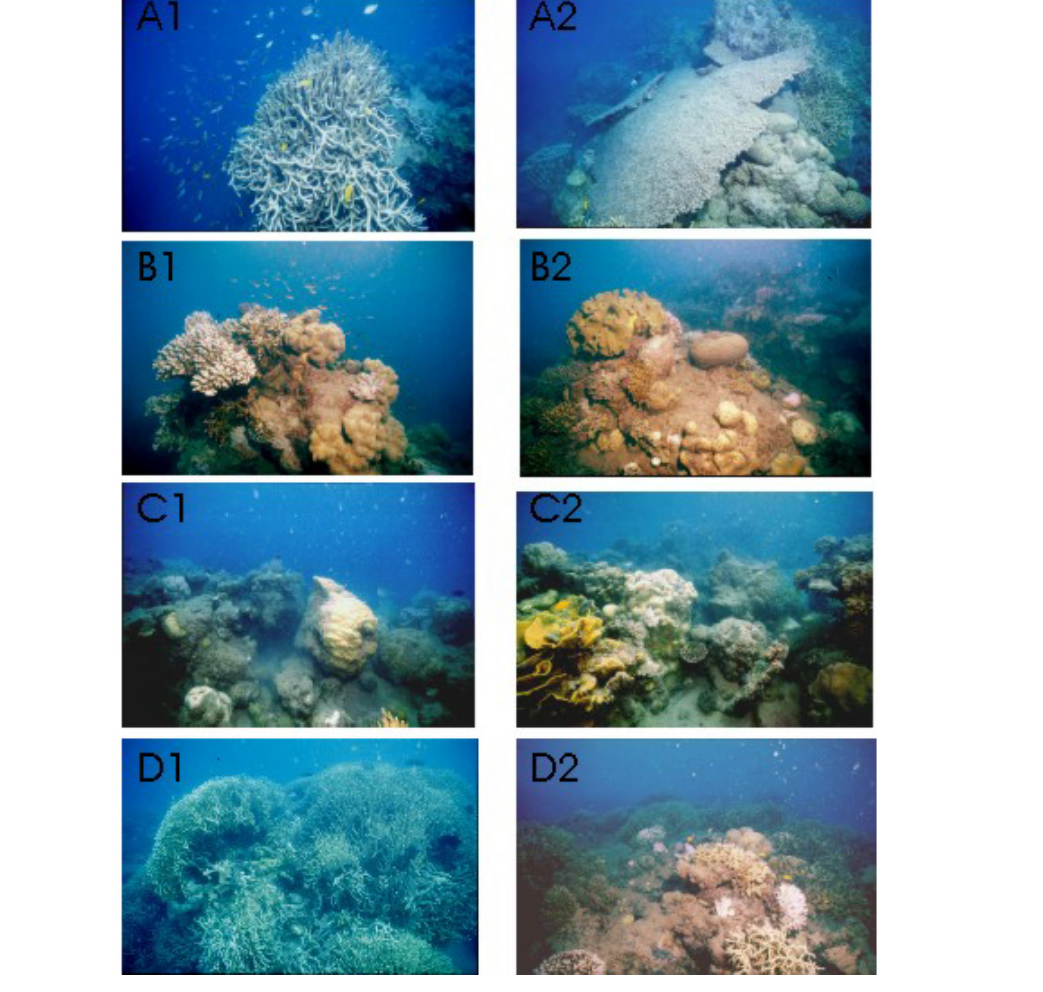
Fig. 7 . Two representative photographs for each health group identified by the regression tree analysis. Photographs A1 and A2 from health group depict low damage and high branching corals or perceived activity. Photographs B1 and B2 from health group B depict low damage and low cover of branching corals or perceived activity. Photographs C1 and C2 from health group C depict high damage and low cover of branching corals; note also the overturned corals. Photographs D1 and D2 from health group D depict high damage and higher cover of branching corals; note that the damage consists of broken